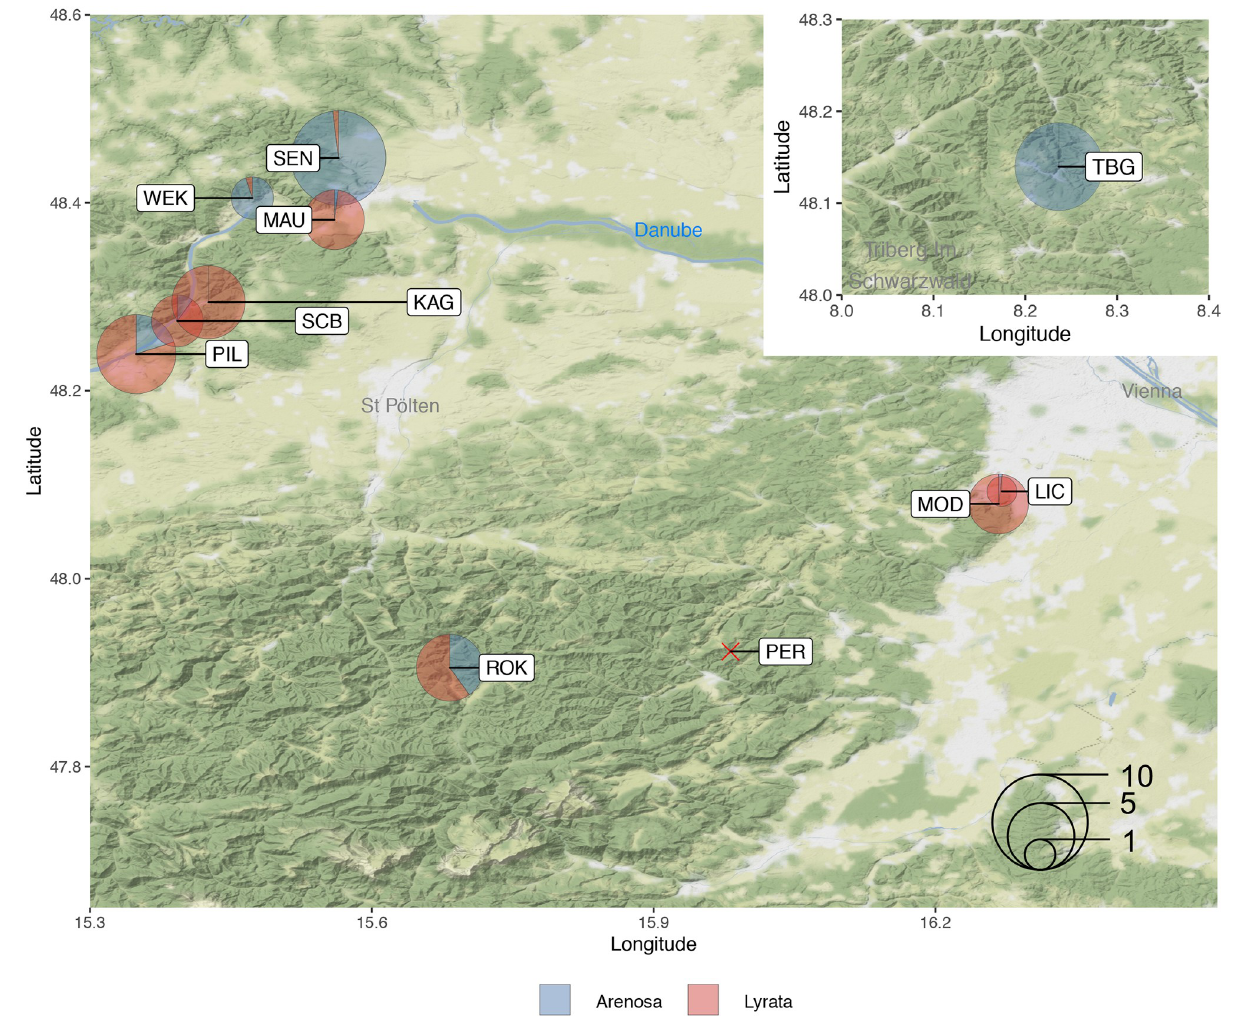
Fig 1. Map of maternal seed lines collection sites from the eastern Austrian fore Alps and Wachau valley. Collection sites are indicated as circles for tetraploid plants and an X for diploids. Pie chart circle size represents the numbers of plants sampled and analysed from each site and the proportion indicates the relative amounts of admixture between A . lyrata (red) and A . arenosa (blue) populations determined in [25].